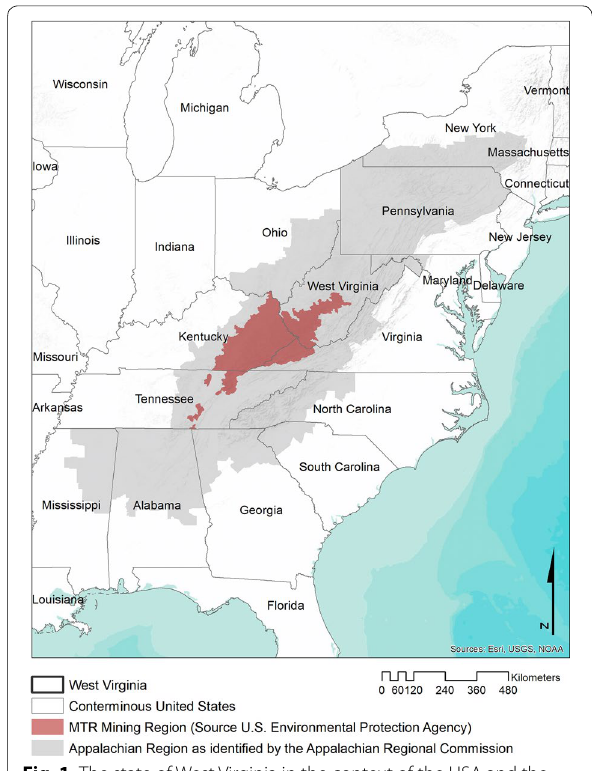
Fig. 1 The state of West Virginia in the context of the USA and the Appalachian